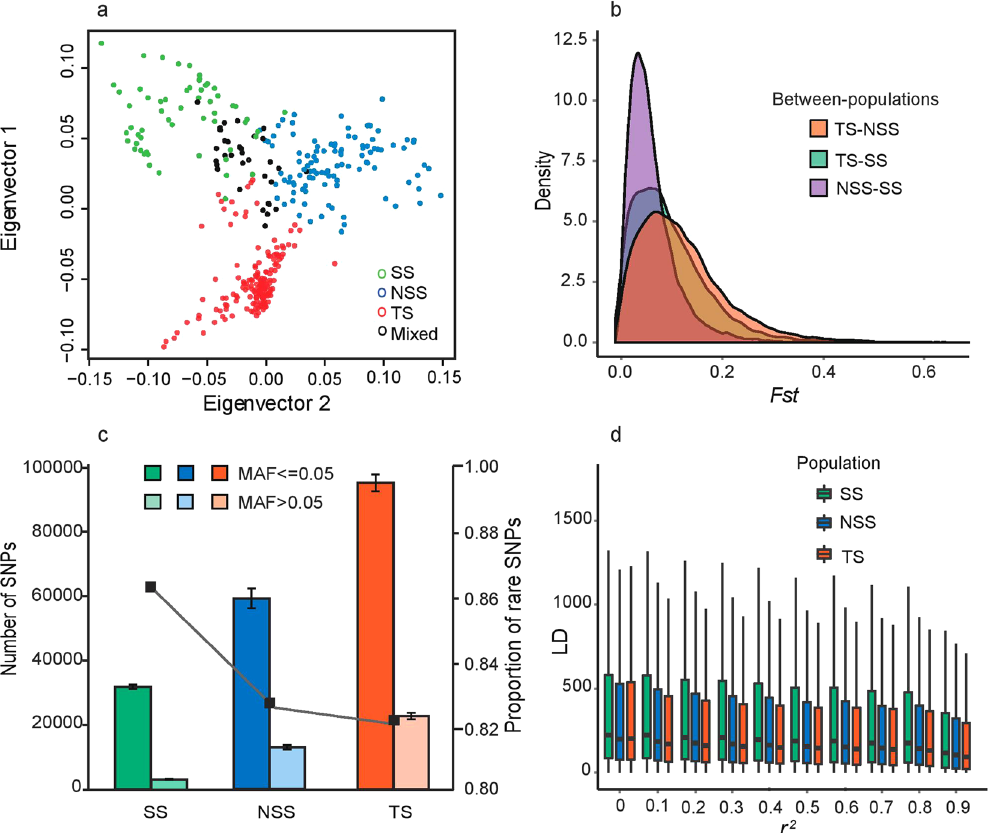
Figure 1. Population structure and characteristics of TS, SS and NSS populations. ( a ) Principal component (PC) analysis of all populations. The first two PCs are shown. Each individual is represented by one dot, colored according to population assignment. ( b ) Pairwise Fst for 1 Mbp sliding windows with a step size of 0.2 Mbp between populations. ( c ) The vertical bars indicate the total number of population-specific common (MAF > 0.05) and rare (MAF ≤ 0.05) SNPs, and the line plot shows the proportion of rare SNPs. ( d ) Boxplot charts of linkage disequilibrium (LD) decay distance estimated for categorized r 2